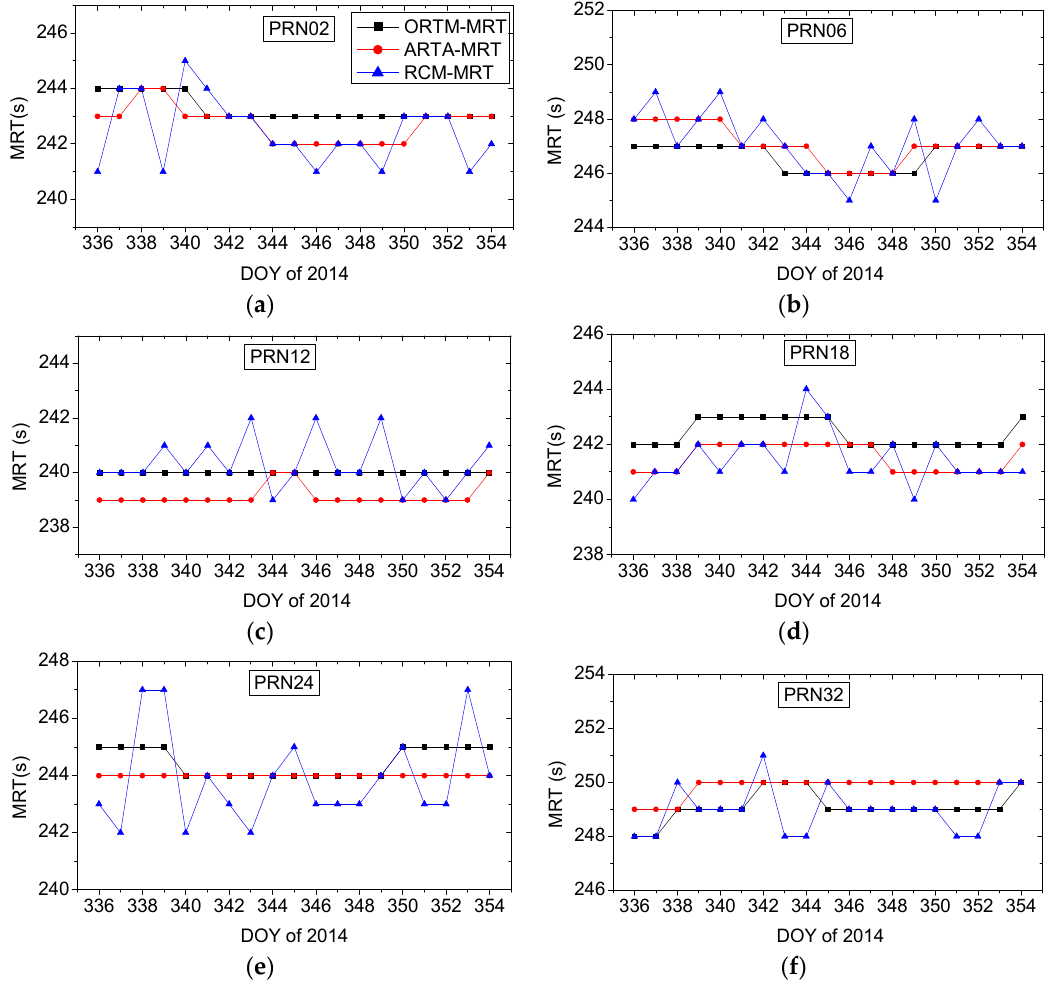
Figure 4. ORTM-, ARTA-, and RCM-derived MRT estimates for PRN 02, 06, 12, 18, 24, and 32. The y -axes denote the daily advance time. MRT estimate equals 86,400 s minus daily advance time. Legend shown on ( a ) is for the all ( a – f ).